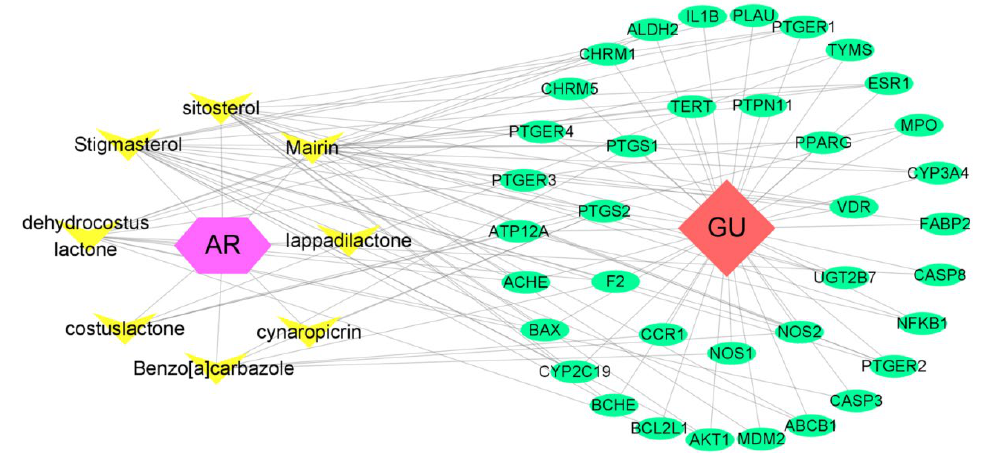
Figure 3. Compound–disease–target network. The purple hexagon represents AR. The yellow triangle represents the active compound contained in AR. The red diamond represents GU. The green ellipse represents the